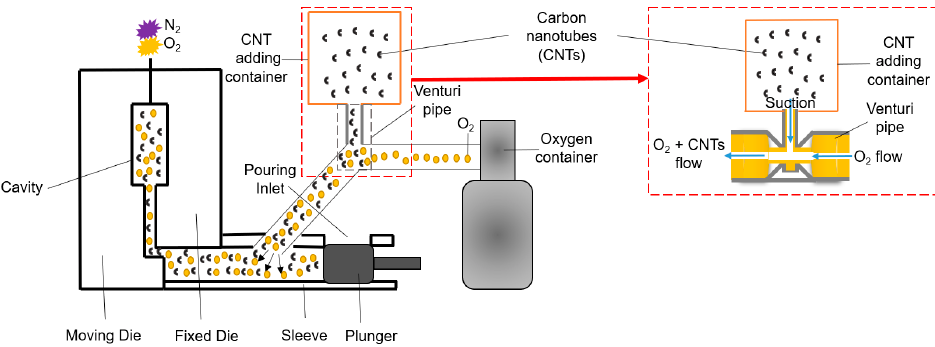
Figure 2. Schematic of experimental setup for fabricating composites using ORDC with CNT-adding system.